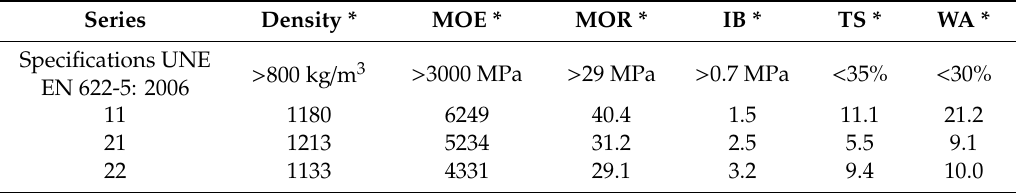
Table 5. Results that allow for a comparison between series 11, 21, and